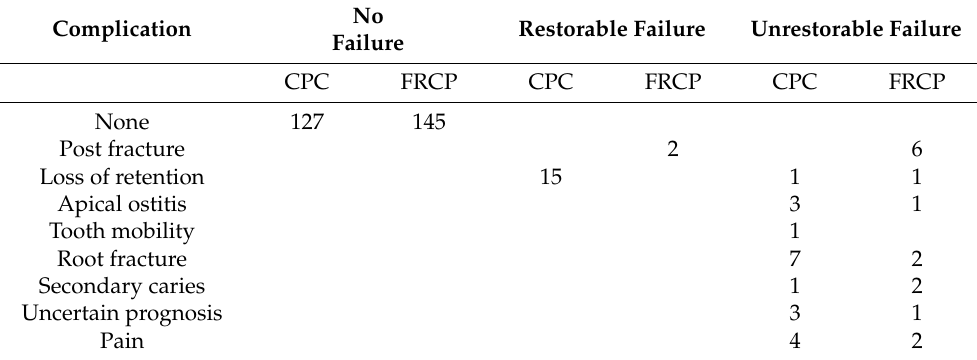
Table 4. Proportion of failure rates and failure modes of the cast post-and-core system (CPC) and the fiber-reinforced composite resin posts (FRCP).